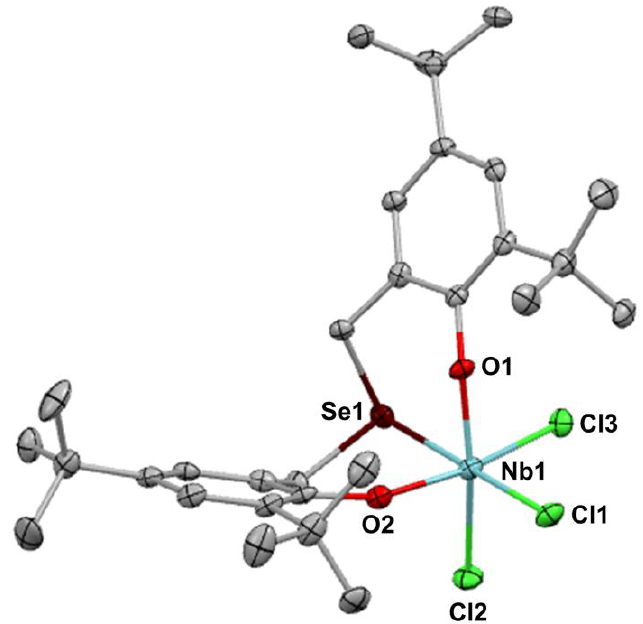
Figure 1. ORTEP of fac - 4 with thermal ellipsoids at 30% probability. All hydrogen atoms and one of the two crystallographically independent molecules of 4 in the unit cell are omitted for clarity.